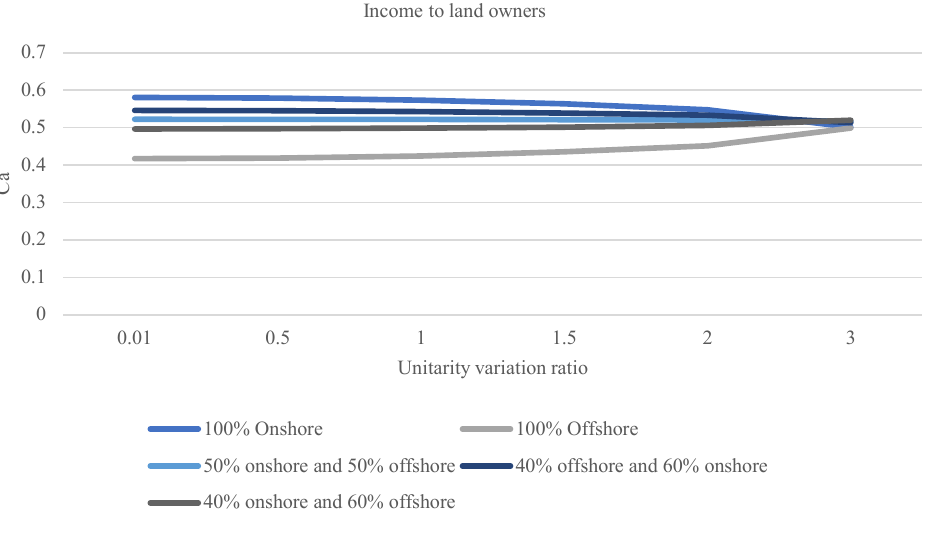
Fig. 5(h). Sensitivity analysis of Jobs.